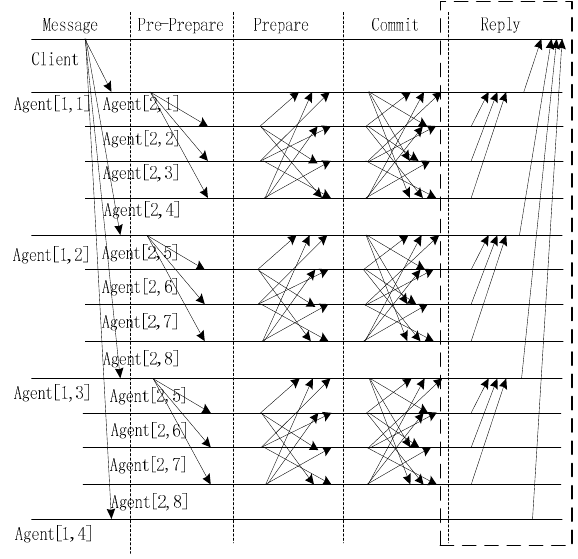
Figure 5. Reply process of the SDMA-PBFT algorithm.